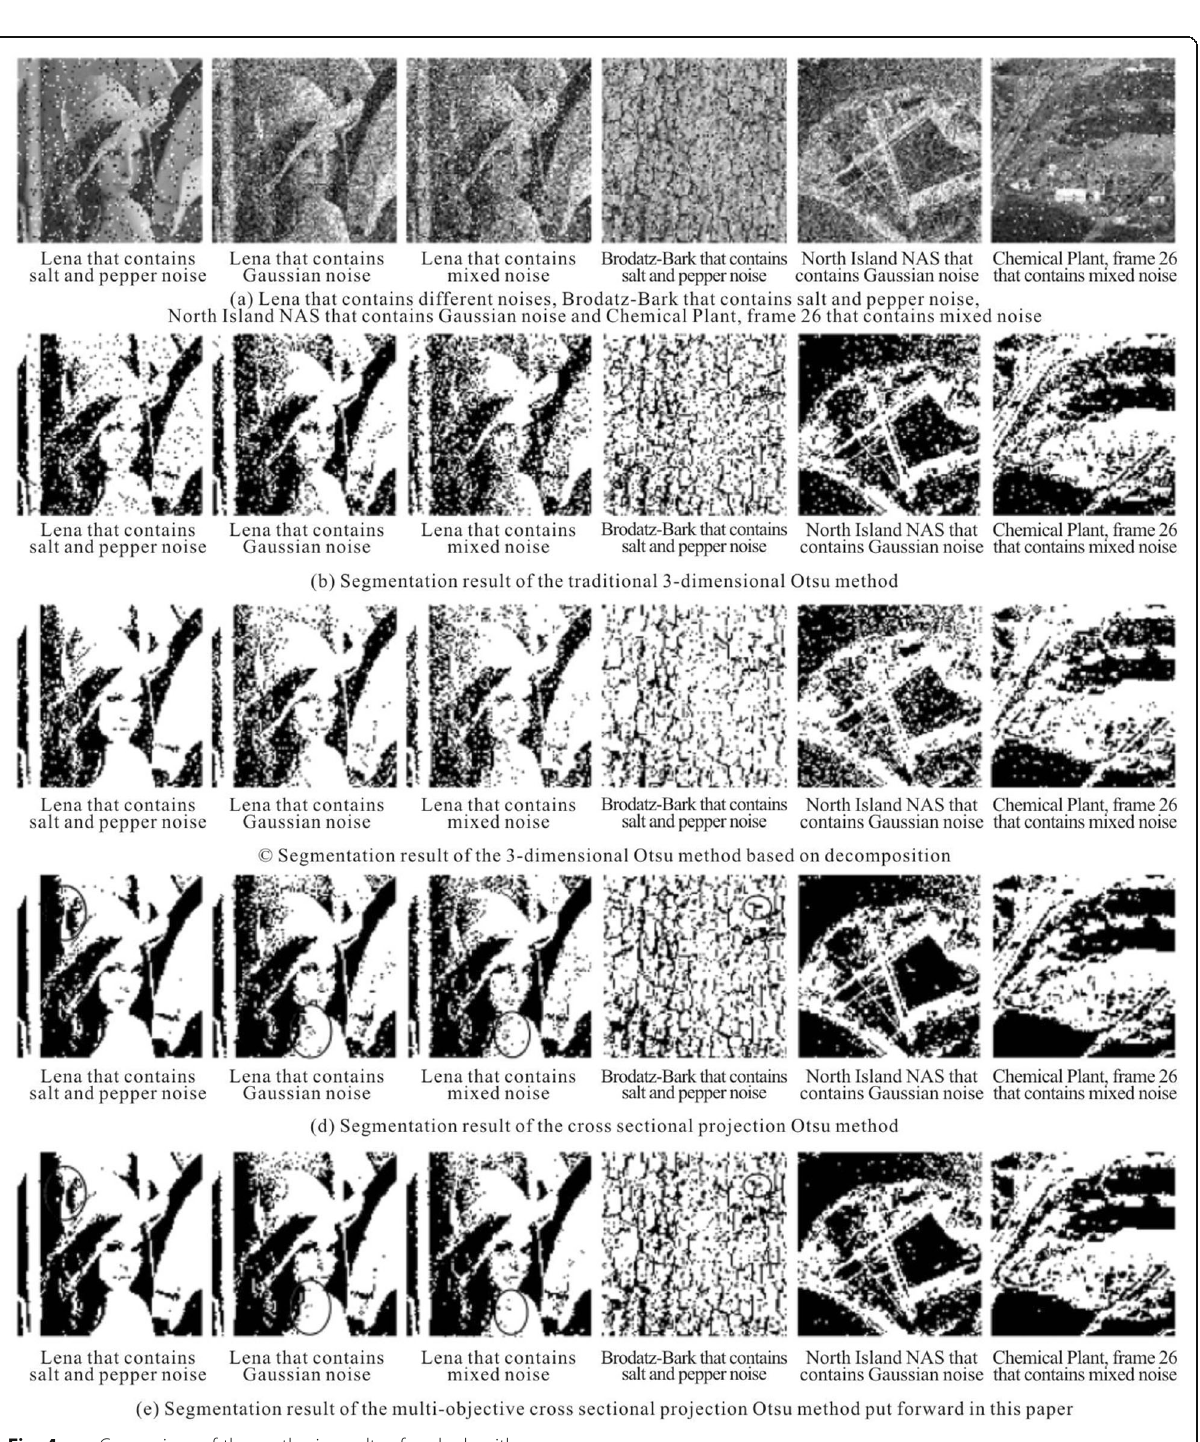
Fig. 4 a – e Comparison of the synthesis results of each